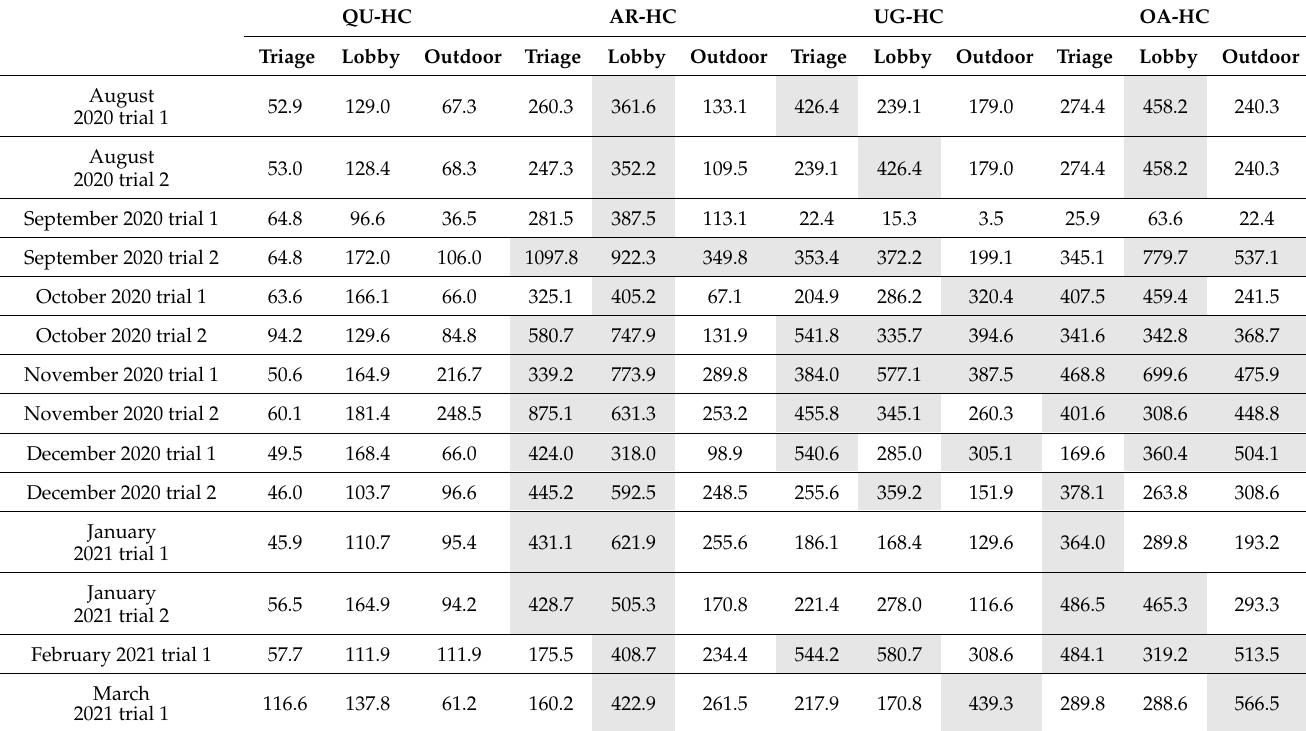
Table 2. Total CFU count of airborne bacteria during the period of August 2020–March 2021 for the four health centers.